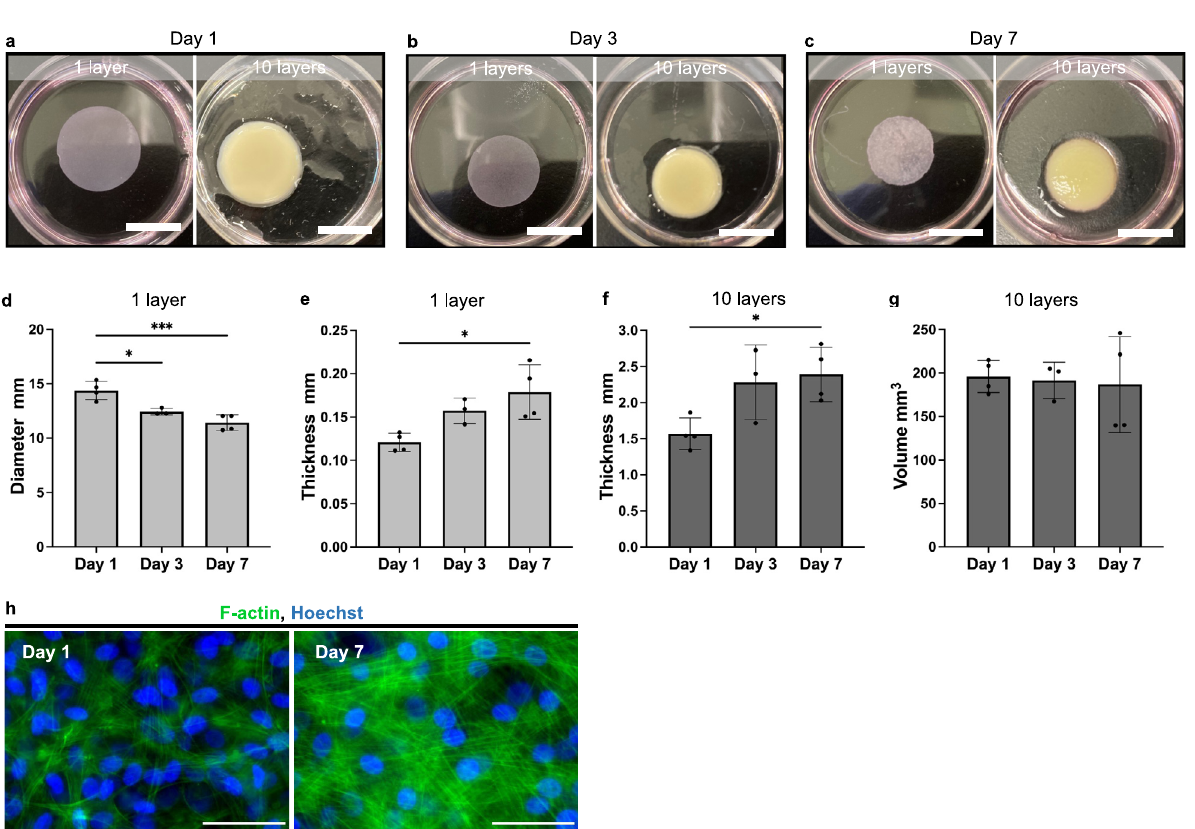
Fig. 2 Dimensional and structural characteristics of the bovine myoblast cell sheets. a – c One and 10-layered-bovine myoblast cell sheets. a day 1 of culture. b day 3 of culture. c day 7 of culture. Scale bar: 1 cm. d Diameter and ( e ) thickness of the individual bovine myoblast cell sheets ( n = 4). f Thickness and ( g ) volume of the 10-layered-bovine myoblast cell sheets ( n = 4). h Representative immuno fl uorescent images of bovine myoblast cell cytoskeleton (Green: F-actin, blue: Hoechst). Left: day 1 of culture. Right: day 7 of culture. Scale bar: 50 μ m. In ( d – g ) the data points represent individual values and error bars represent SD. * P < 0.05, ** P < 0.01 was considered signi fi cant in the analysis between groups using one-way ANOVA, with Tukey ’ s